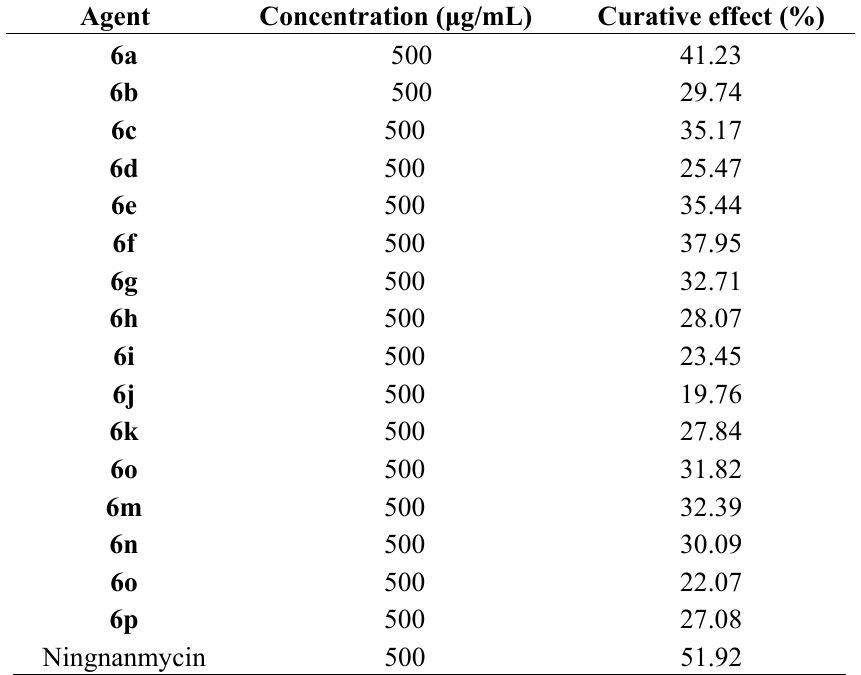
Table 3. The curative effect of the compounds 6a – p against TMV in vivo